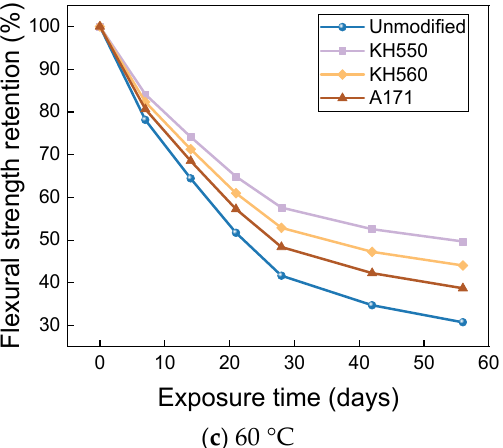
Figure 28. Flexural strength retention in a 10%NaOH alkaline environment. Hydrolysis of resin under alkaline environments.